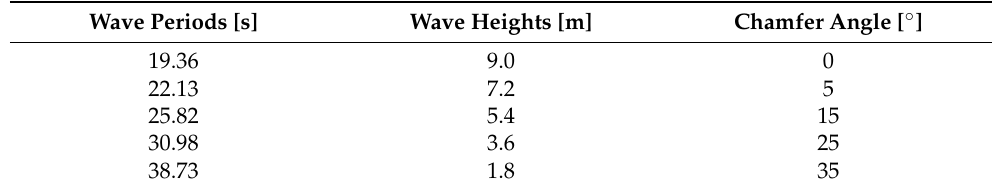
Table 4. The working condition of numerical simulation. Wave Periods [s]